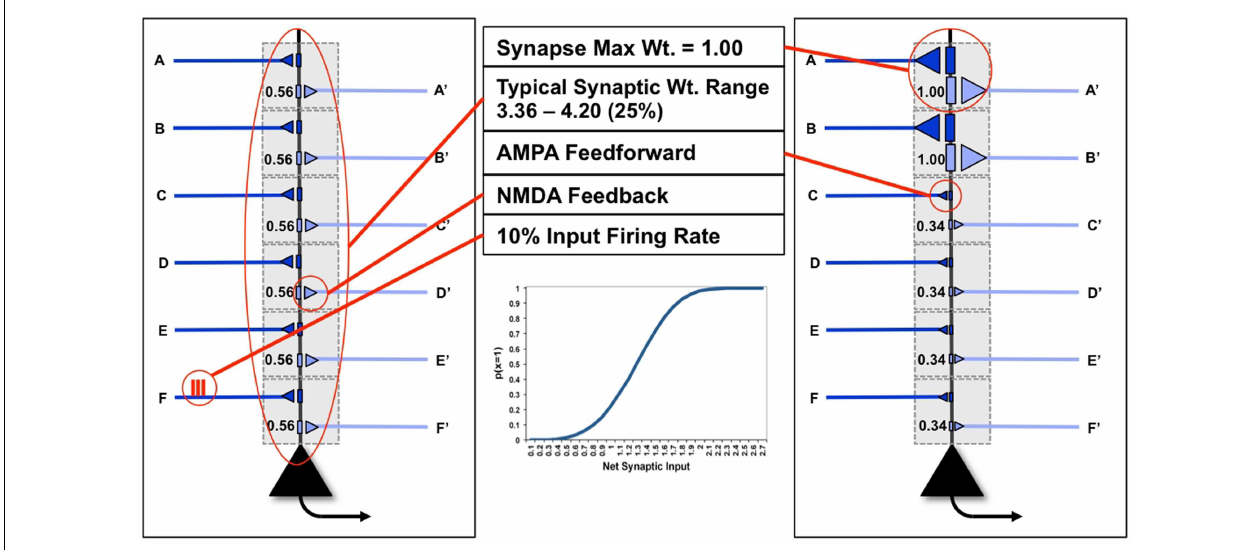
FIGURE 1 | “Uniform”and “specialized”neurons and their parameters .The neuron on the left shows “uniform” synapses, while the neuron on the right has become “specialized” for coincident inputs on synapses A/A (cid:48) and B/B (cid:48) .The inset shows the sigmoid firing probability of modeled neurons.